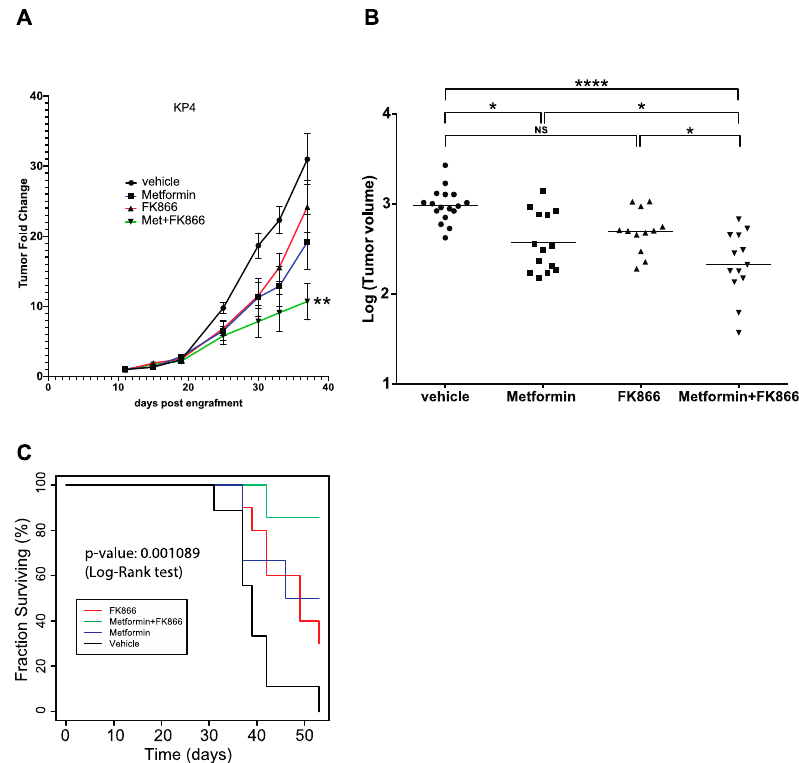
Figure 4. Progression of KP4 sub-cutaneous xenografts in nude mice. ( A ) Xenograft tumor growth of KP4 cells engrafted subcutaneously in nude mice. Metformin (75 mg/kg/d), FK866 (20 mg/kg/d), Met+FK, or vehicle treatments (intraperitoneally 5 days per week) were started 11 days post-engraftment. * p ≤ 0.01, ANOVA. ( B ) Graph showing the volume of each tumor after 37 days of the different treatments. * p ≤ 0.05, **** p ≤ 0.0001, NS: not significant (ANOVA). ( C ) Kaplan–Meyer survival curve of KP4 tumor-bearing mice as in ( A ) over 54